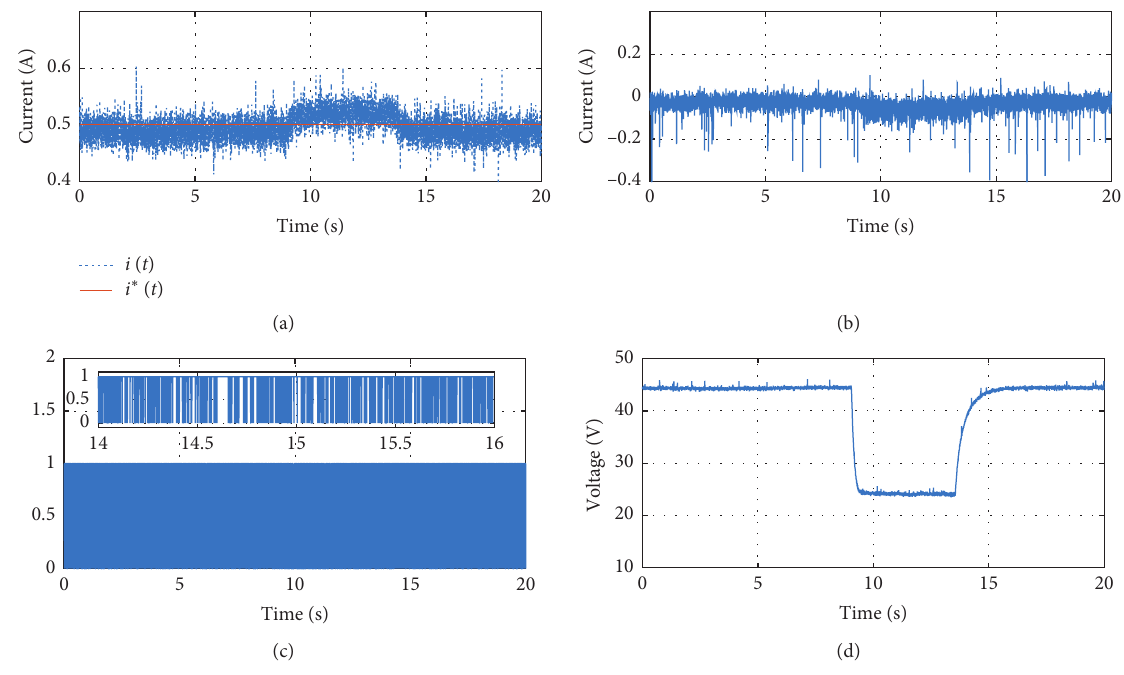
Figure 23: Boost converter response to disturbances, FOSM controller. (a) Desired current and measured current. (b) Error. (c) Control action. (d) Output voltage.